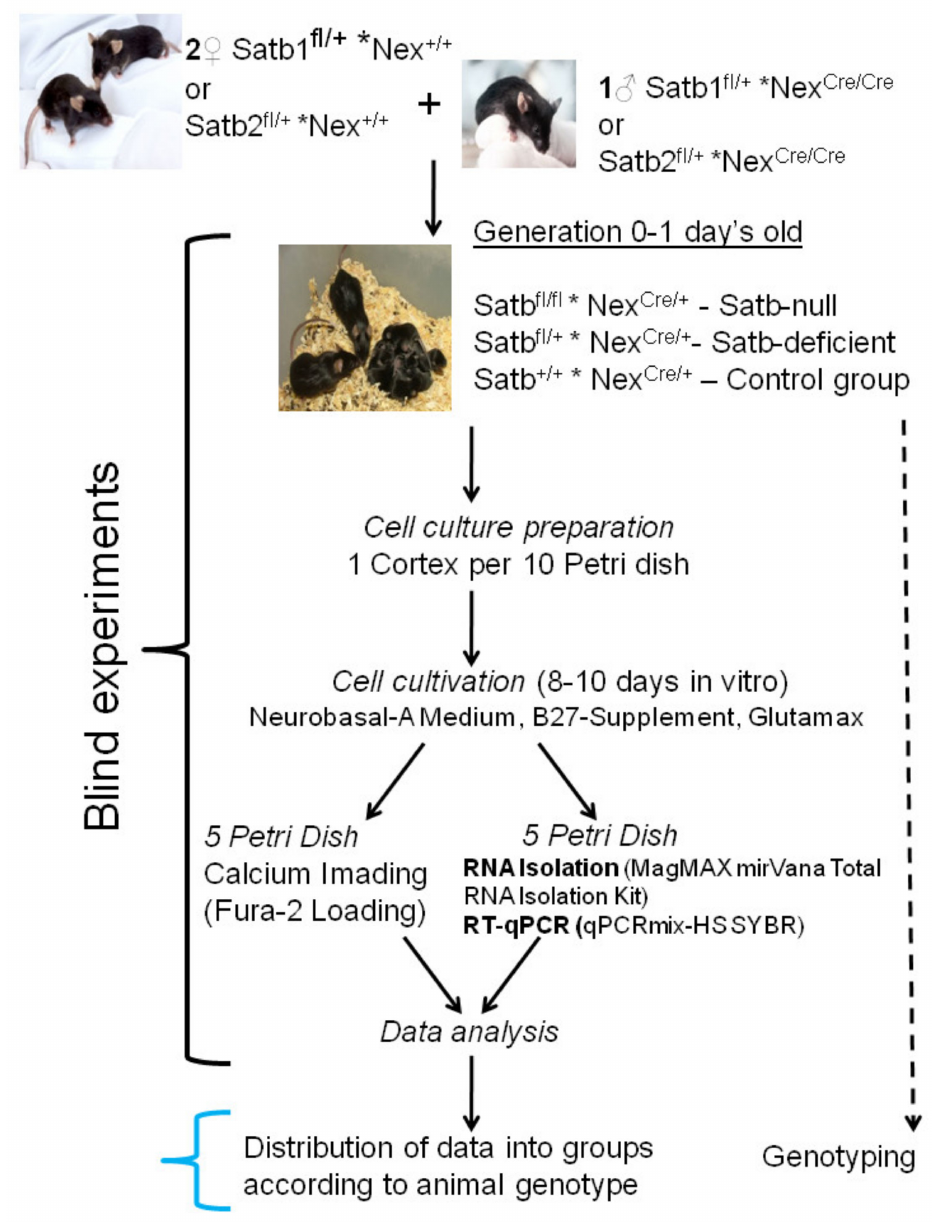
Figure 1. An experimental strategy. In the generation there was Satb-deficient (Satb fl/+ * Nex Cre/+ ), Satb-null mice (Satb fl/fl * Nex Cre/+ ) and Control (Satb +/+ * Nex Cre/+ ) mice. The cerebral cortex